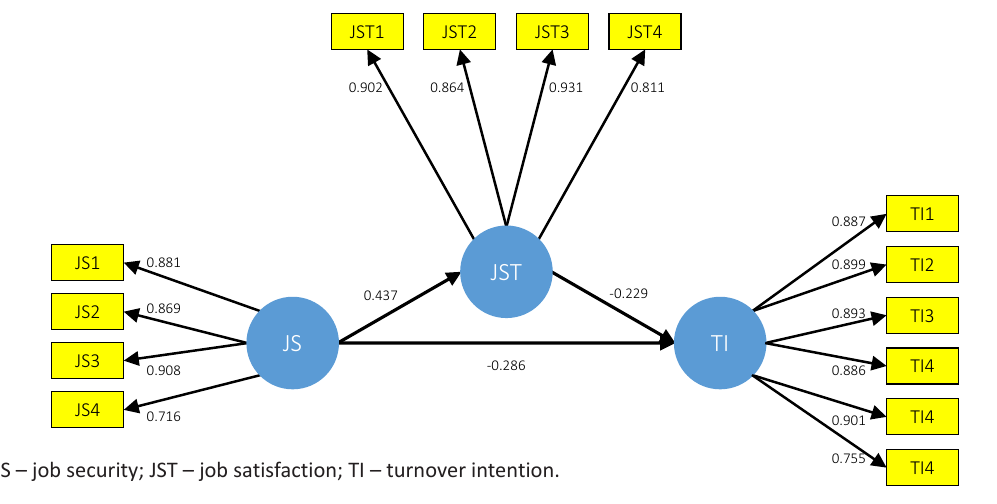
Figure 3. Final Table 5. Path coefficients according to a complete bootstrapping routine